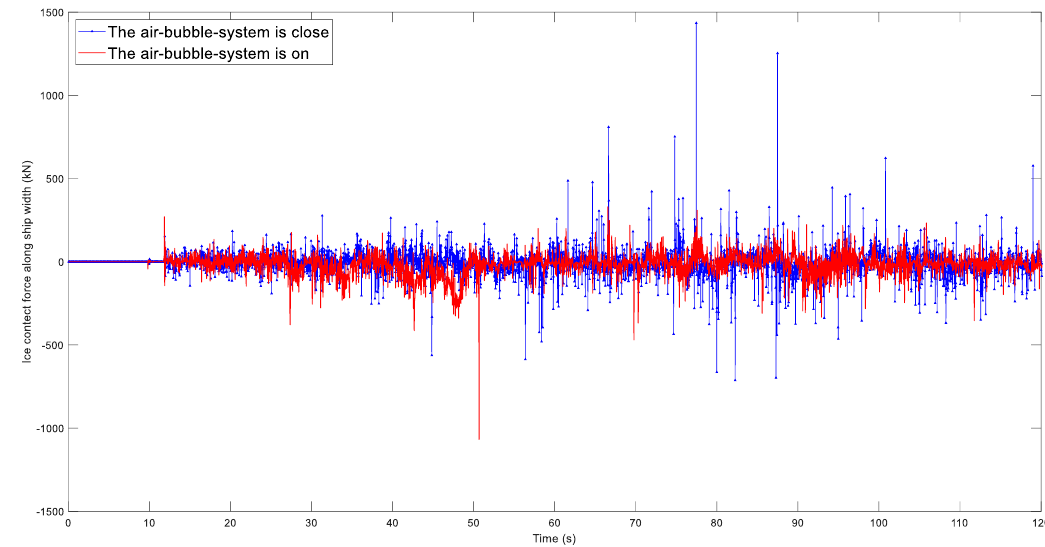
Figure 12. Comparison of time history curves of ice contact force along ship width.